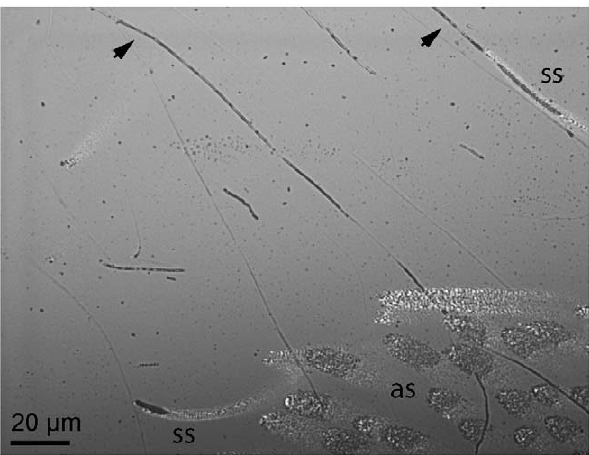
Figure 4. Evidence for tarsal silk in the tarantula Grammostola rosea . Silk strands are indicated with arrows. Adhesive setae (as; lower right) far outnumber silk-producing setae (ss) on the tarsus. Dark areas indicate fluid or silk secretion; bright areas indicate thin layers of air between the setae and the glass surface. See Video S5 for complete time-lapse video footage of silk being secreted.